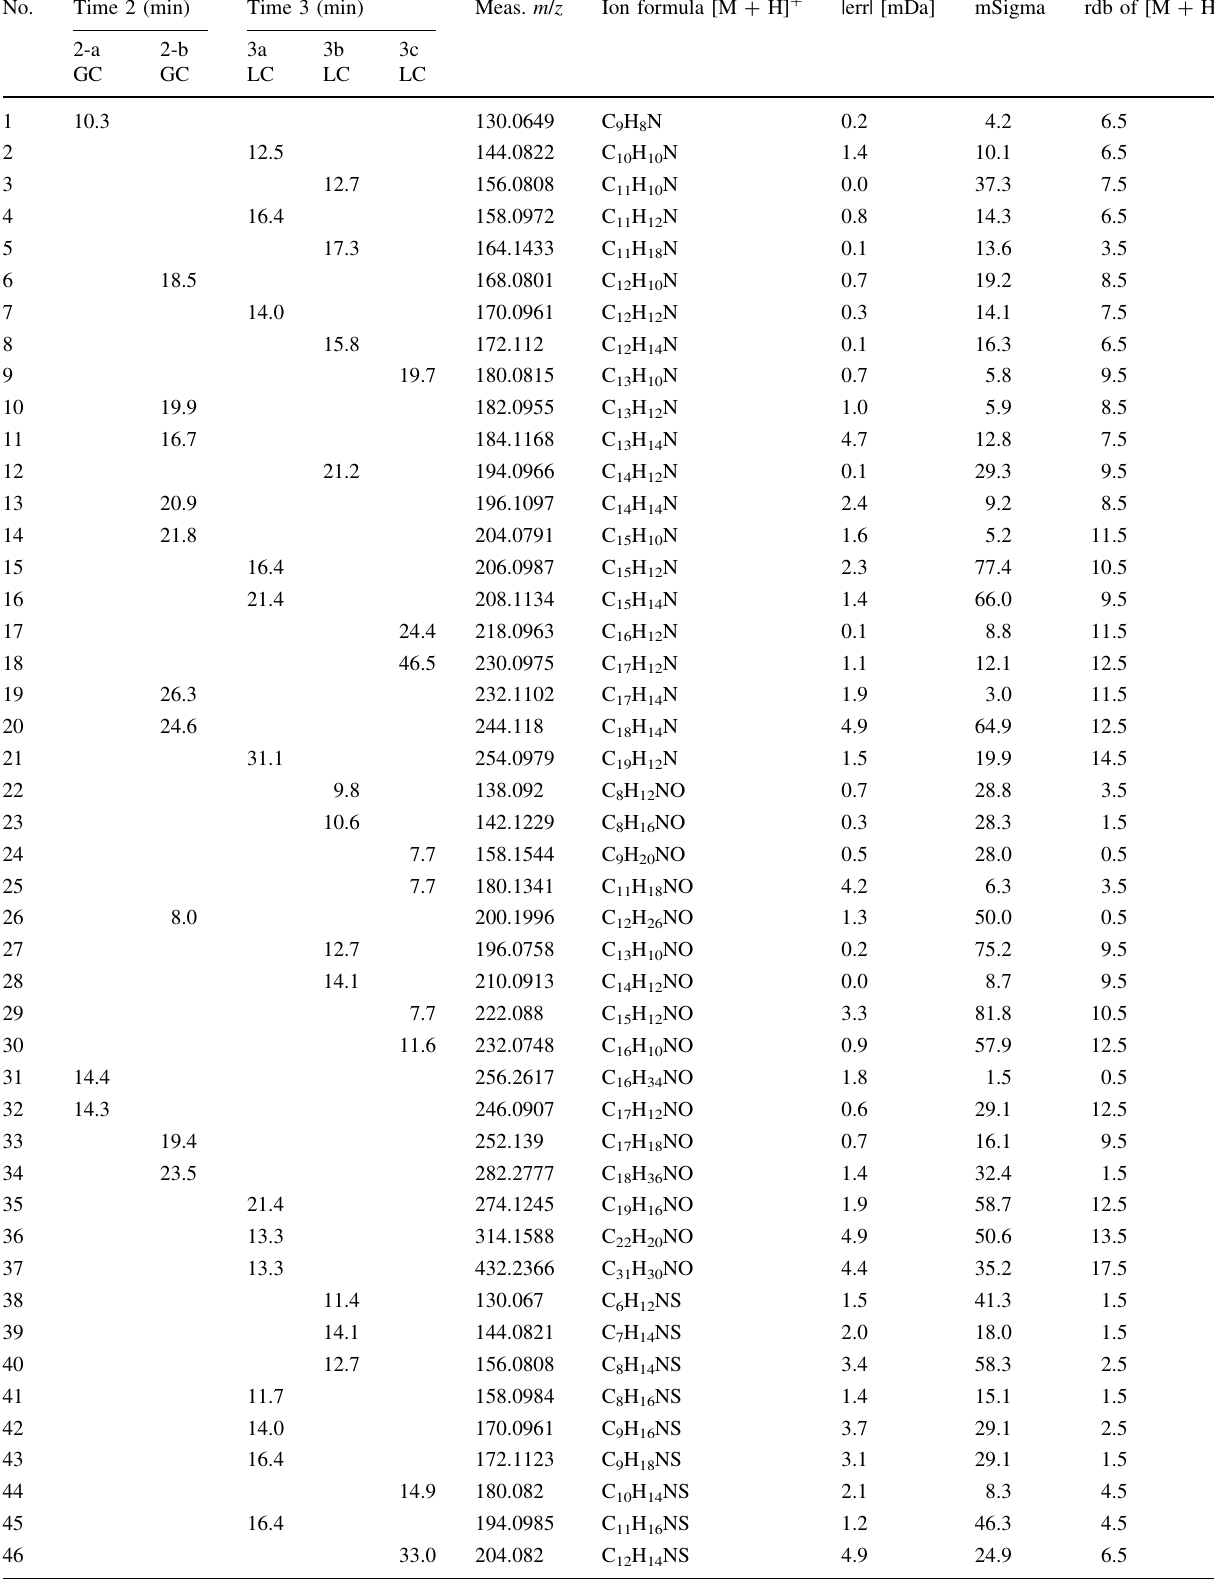
Table 1 Tentatively N-compounds identified in Figs. 2 and